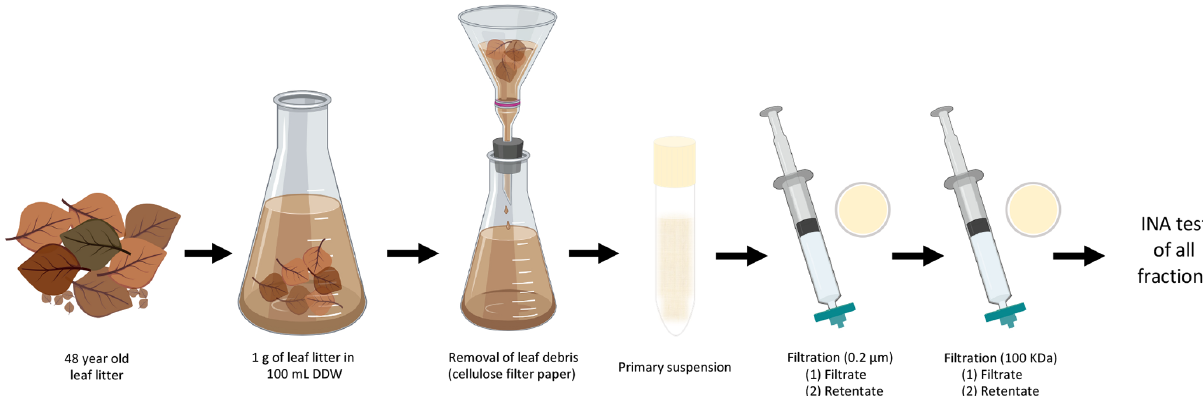
Figure 1. Characterization of INA of aspen leaf litter 70-S-14. For each biological replicate ( n = 4), 1g of aspen leaf litter was suspended in 100mL of sterile double-stilled water (DDW). The primary suspension, the filtrates, and the filter retentates of the 0.22µm and the 100kDa filters were tested for INA. In parallel, a portion of the primary suspension and of both filtrates and of both filter retentates were boiled for 15min and tested for INA as